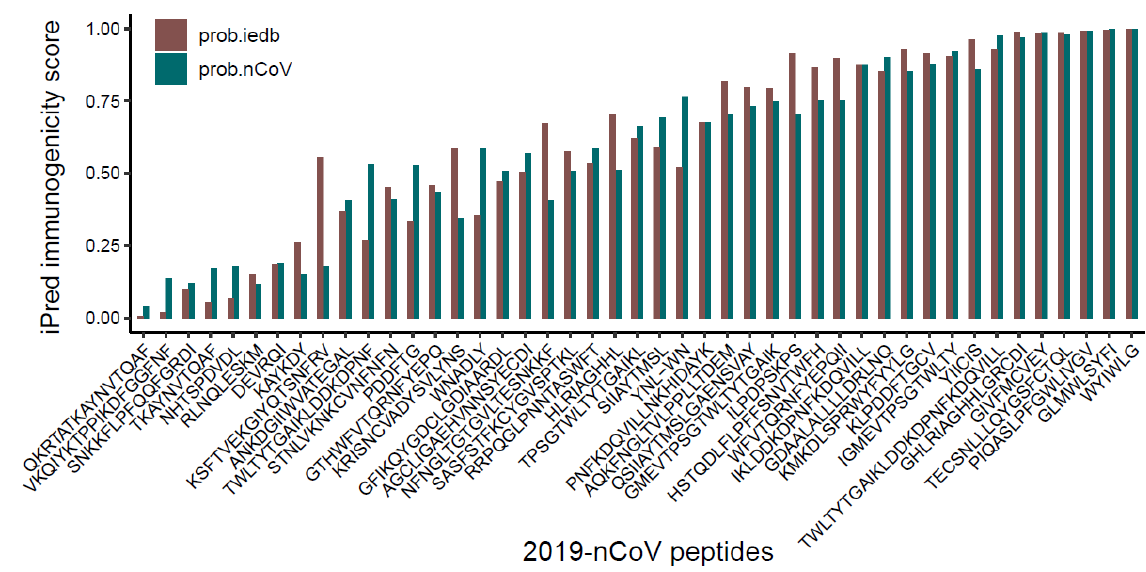
Figure 2. Predicted immunogenicity for IEDB immunogenic vs. 2019-nCoV peptides. 2019-nCoV peptides having a high sequence similarity to immunogenic peptides and their targets were analysed for their immunogenicity potential by iPred algorithm.